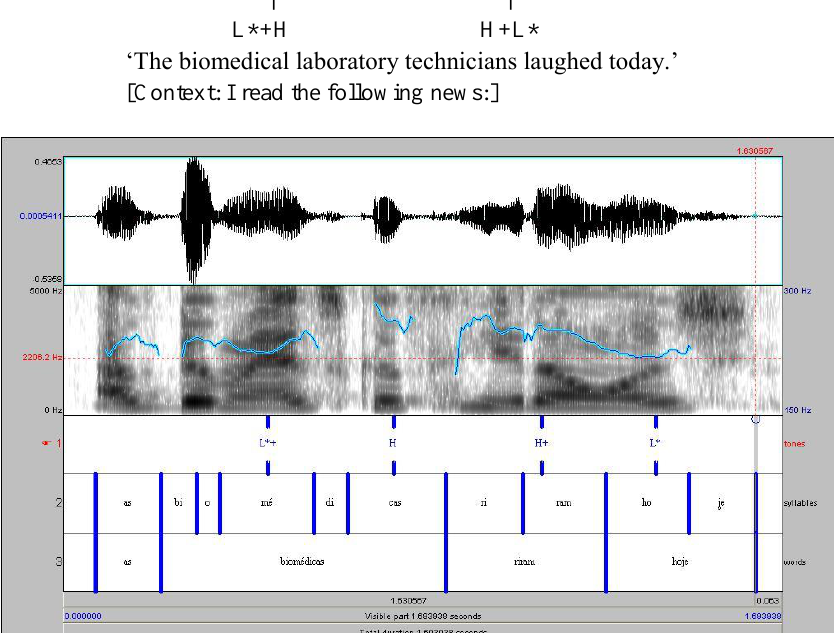
Figure 2. F 0 contour of the neutral sentence As biomédicas riram hoje ‘The biomedical laboratory technicians laughed today’ produced by T in neutral